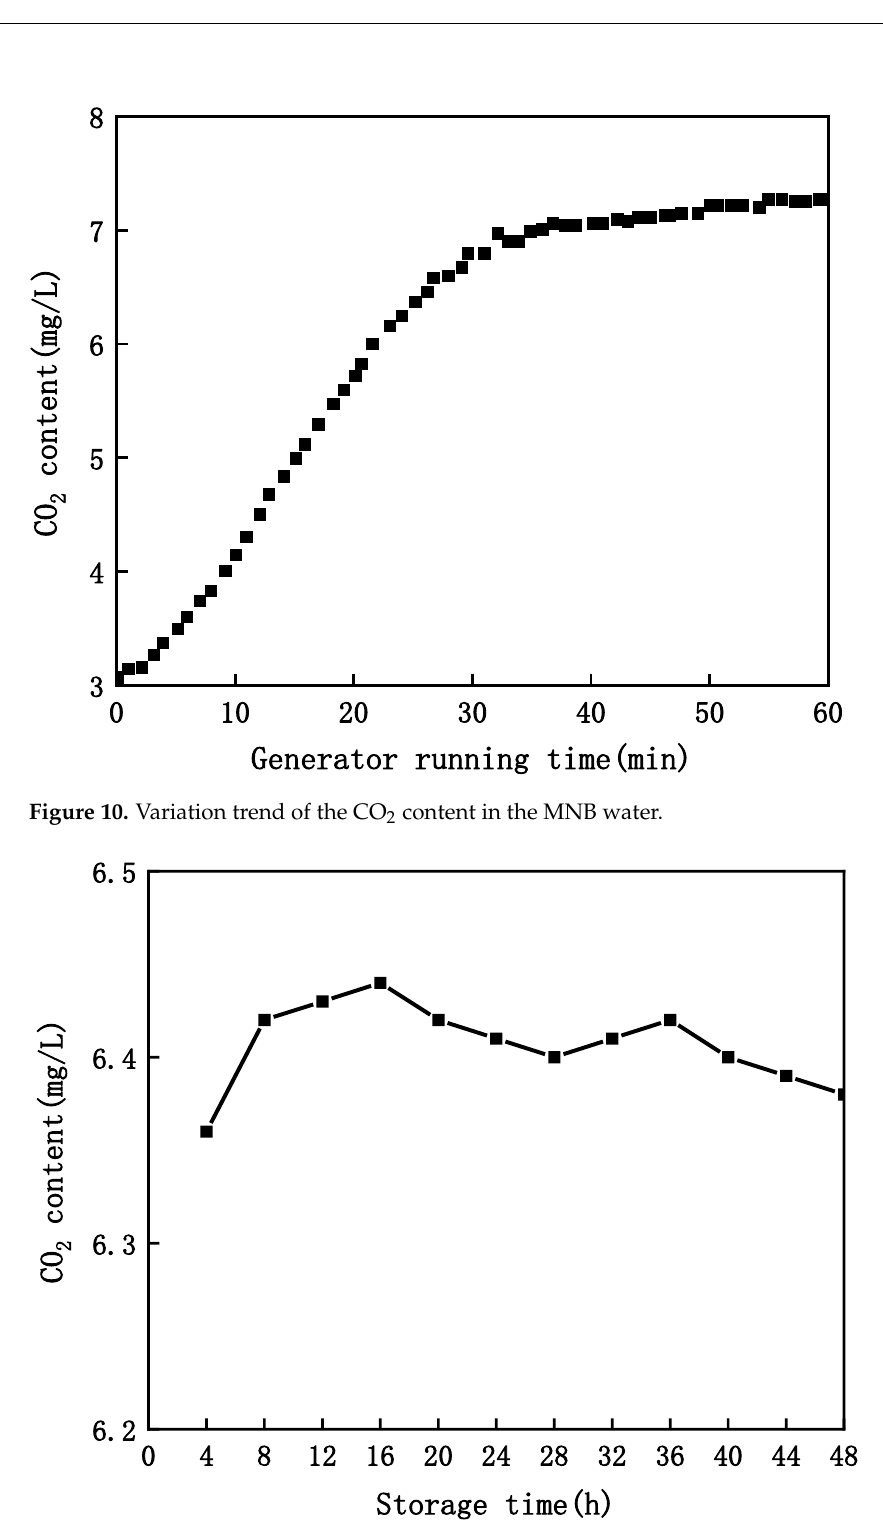
Figure 11. Line chart showing the variation of the CO 2 content in the MNB water.